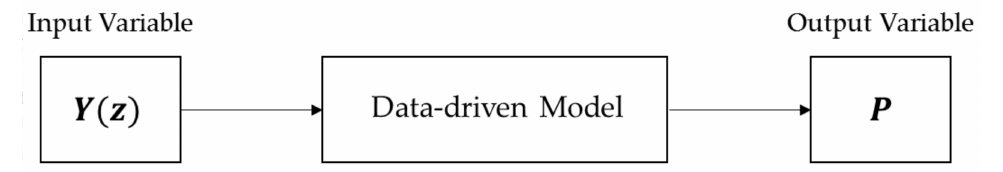
Figure 1. Schematic diagram of the